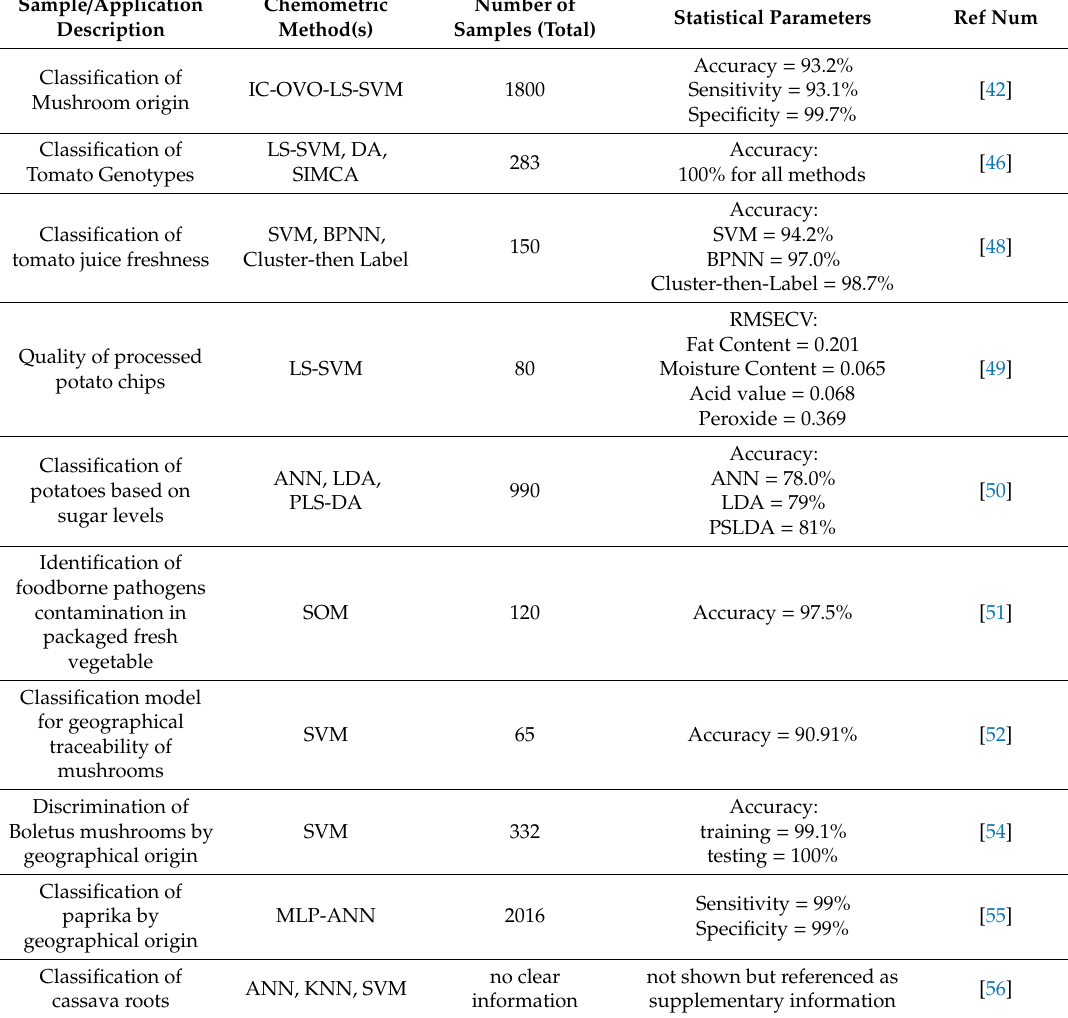
Table 1. Literature related to the use of chemometrics in classification of